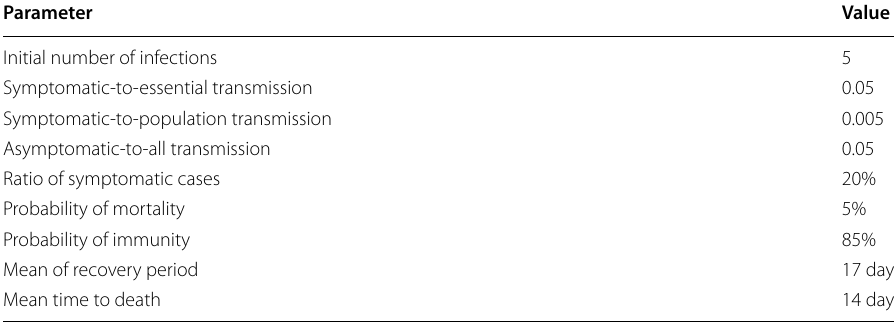
These parameters reflect an intuitive estimation at the time of model construction with the intention to study general trends. The values of these parameters can be changed in the code (see “Methods”